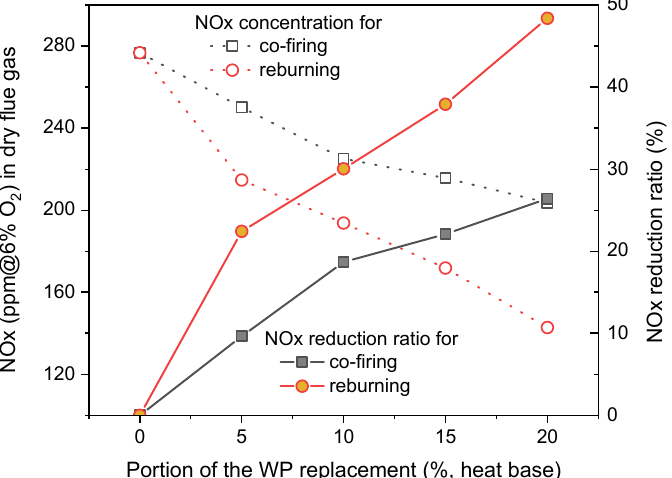
Figure 4. NOx emission and degree of NOx reduction for various WP cofiring and reburning ratios.